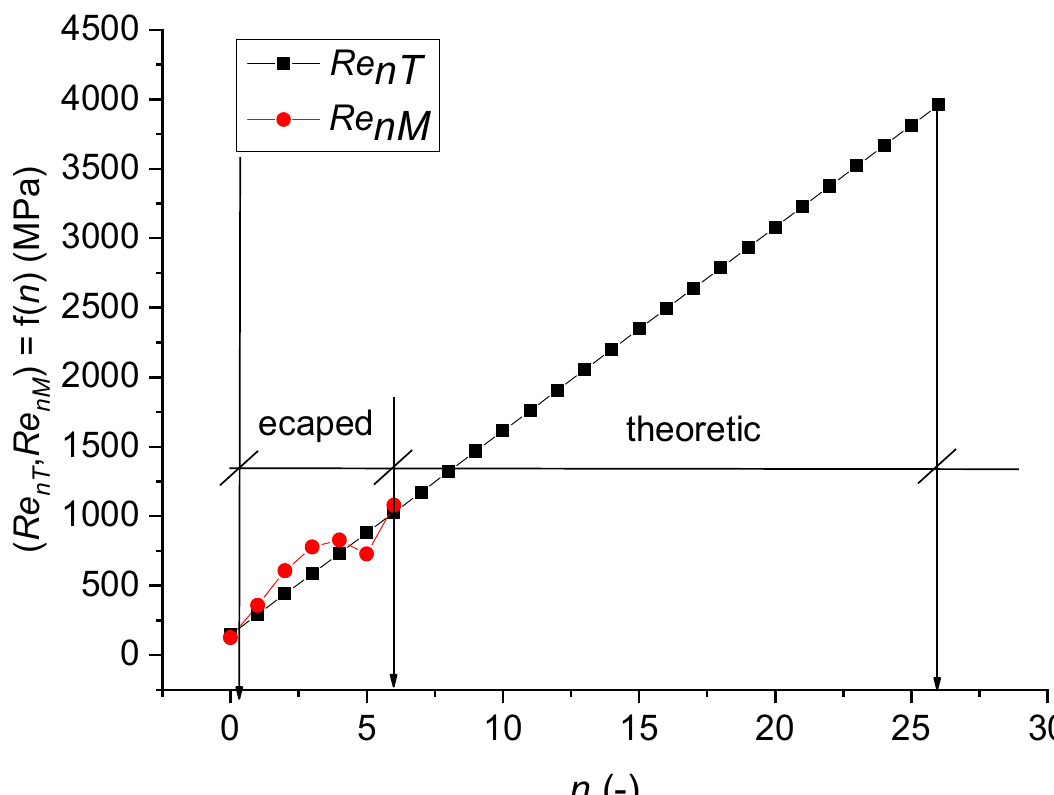
Figure 6. Dependence of ( Re nT , Re nM ) = f( n ).